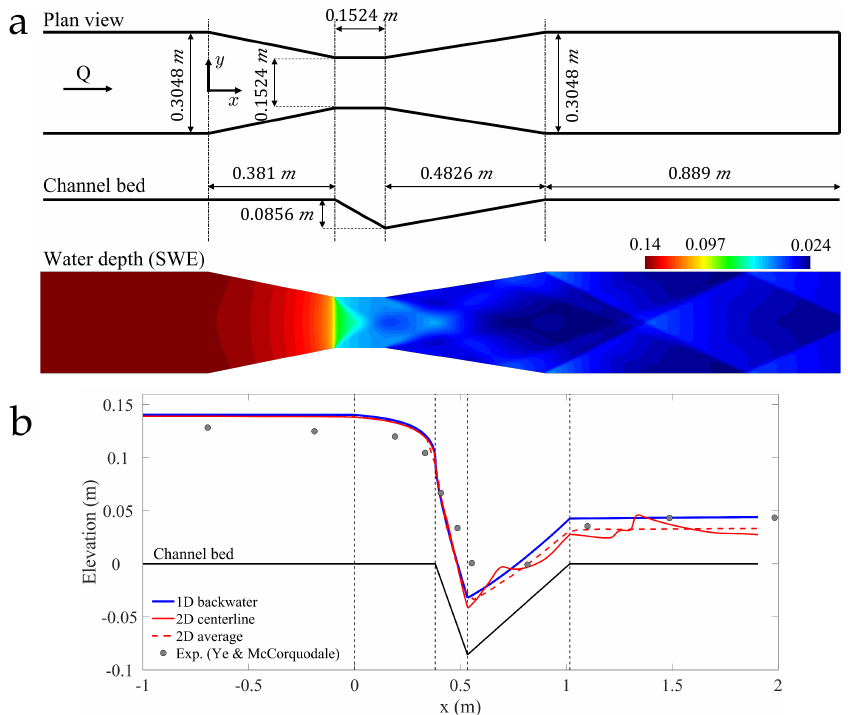
Figure 7. Model validation: transcritical flow in a Parshall flume. ( a ) Schematic description of the flume geometry, according to the experiments of [43], and steady-state water depth for a flow discharge Q = 0.0145 m 3 /s. ( b ) Comparison between experimental observations of water surface profile [43] and model predictions.